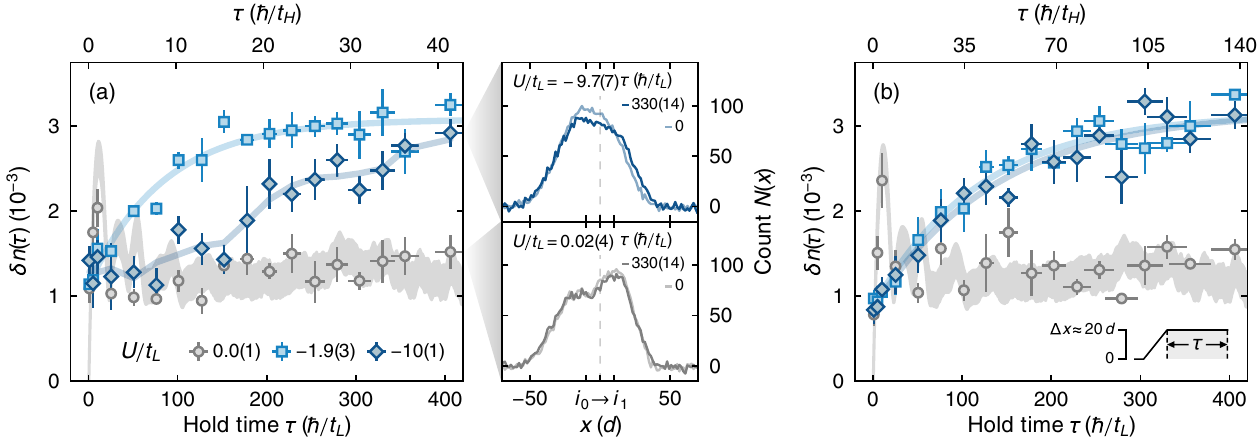
FIG. 4. Late-time relaxation dynamics. Density deviation δ n ð τ Þ of the light atoms with respect to the initial atom distribution after translating the trap minimum by Δ x [see Eq. (2)], for a variable hold time τ > 0 , as illustrated in the bottom-right schematic of panel (b). 0 . 102 ð 6 Þ and (b) 0.34(3). Each data =t The time traces correspond to three heavy-light interaction strengths (see legend) with (a) t H L ¼ point is calculated from the average of 3 – 5 atomic densities and an independent measurement of n ð x; 0 Þ . Error bars (partly smaller than the marker size) denote the uncertainty of τ , determined from the estimated uncertainty of the hopping amplitude t , and standard L error of δ n ð τ Þ , determined from jackknife resampling [42]. The colored lines show exponential fits, as discussed in the main text, and in ≃ − 10 as a guide to the eye. We show our numerical calculation for U ¼ 0 as a gray panel (a), a three-point moving average for U=t L band, with the height derived from the estimated systematic uncertainty of δ n ð τ Þ [42]. The two central panels show integrated atomic densities, which are used to calculate δ n ð τ ¼ 330 ℏ =t in L Þ